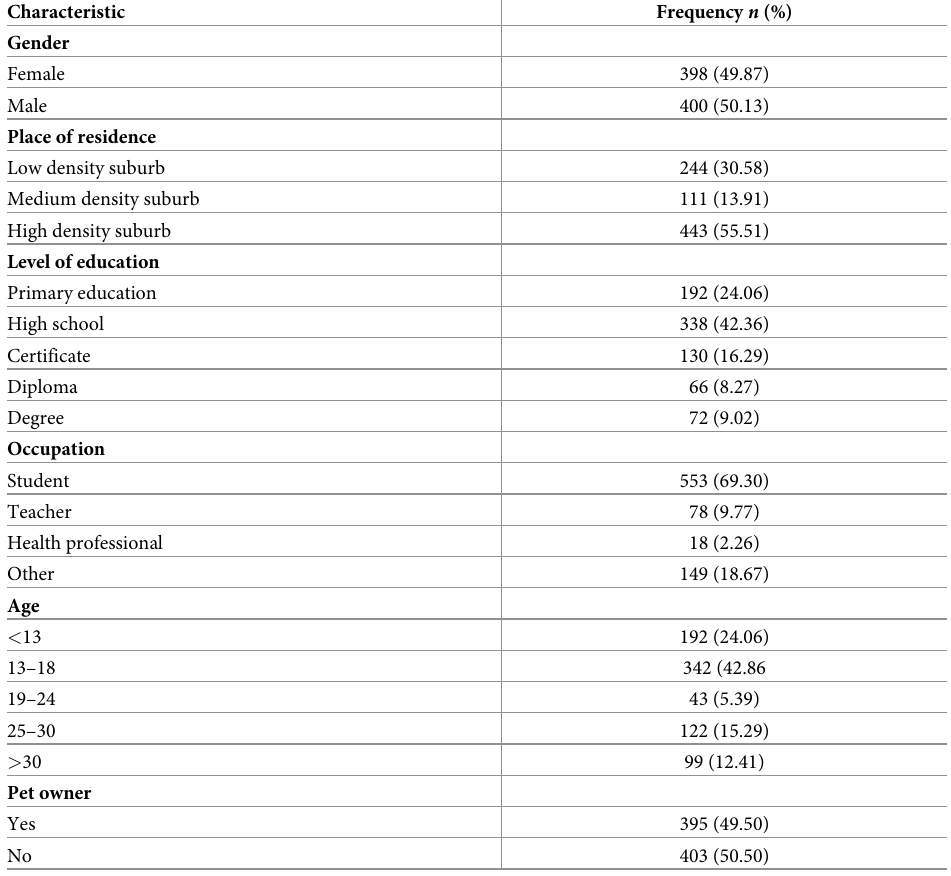
Table 1. Socio-demographic characteristics of the respondents included in the